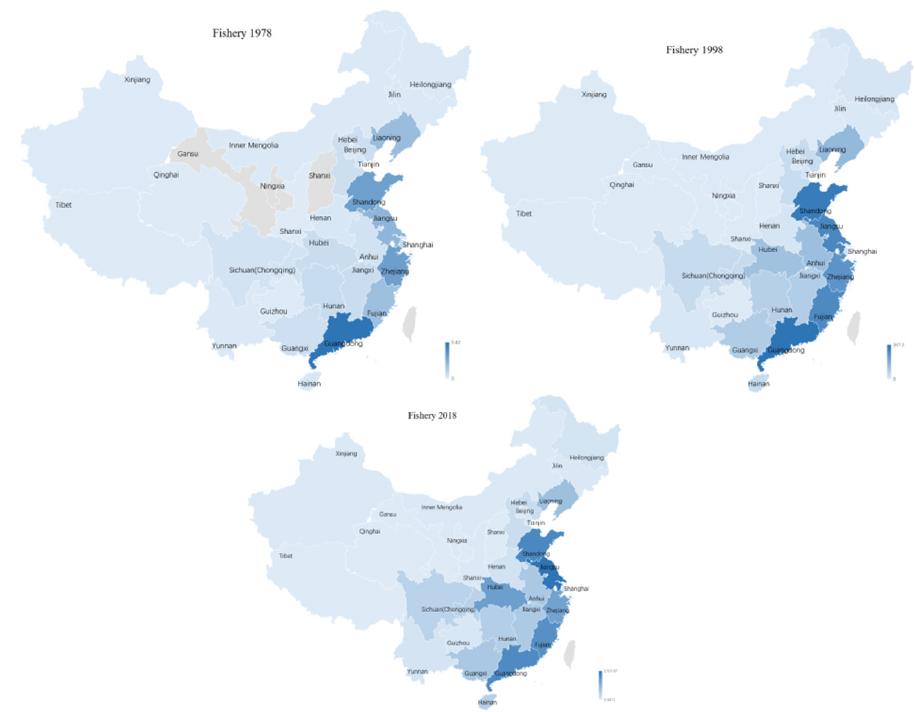
Figure 16. Geographic distribution of fishery GDP in 2018.